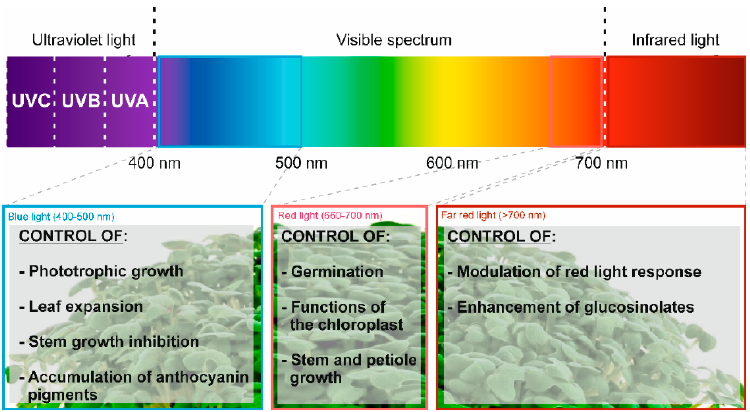
Figure 1. Light spectra influence on the development of kale sprouts.